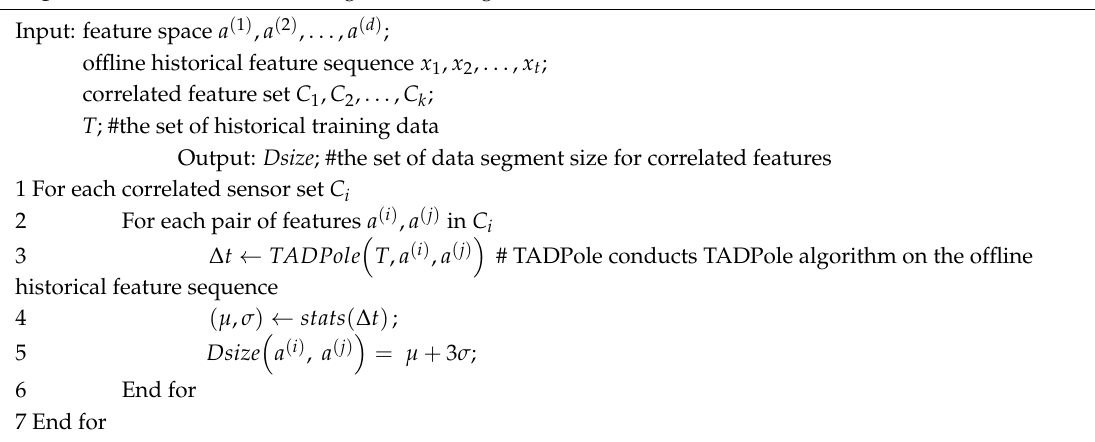
Algorithm 3. DWT-based data segmentation